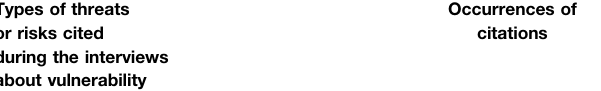
TABLE 7 | Typology of vulnerability ’ s causes cited during interviews about vulnerability. Total of interviews 18.